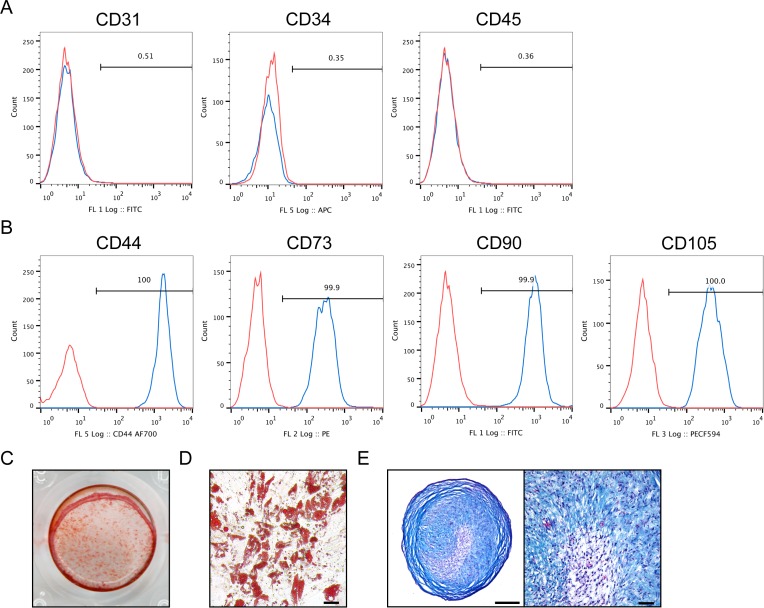
Flow cytometry analysis and multilineage differentiation potential of human culture-derived BMSC.Human BMSC, as defined by culture-adherence to standard culture ware, were examined at passage two by (A,B) flow cytometry and (C–E) in vitro multilineage differentiation potential. (A,B) By flow cytometry, expression is shown in blue in relation to unstained control in red. (A) From left to right: No expression of CD31+/CD34+ endothelial or CD45+ inflammatory cells among culture expanded human BMSC. (B) Near universal expression of canonical ‘MSC’ markers among culture expanded human BMSC, including CD44, CD73, CD90, and CD105 (frequency: 99.7–100%). (C–E) Multilineage differentiation potential of human BMSC, including (C) osteogenic differentiation as assessed by Alizarin red S staining at d7 of differentiation, (D) adipogenic differentiation as assessed by Oil red O staining at d14 of differentiation (Scale bar: 50 μm), and (E) chondrogenic differentiation as assessed by Alcian blue staining of micromass sections as d21 of differentiation (Left scale bar: 250 μm; right scale bar: 50 μm).